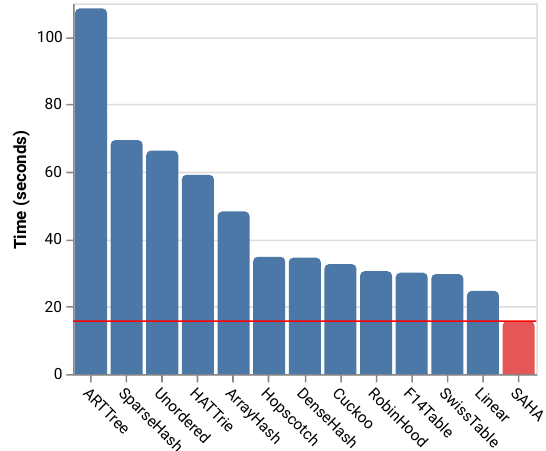
Figure 4. A bar graph of time consumption of various hash tables to process group and join benchmarks compared to SAHA